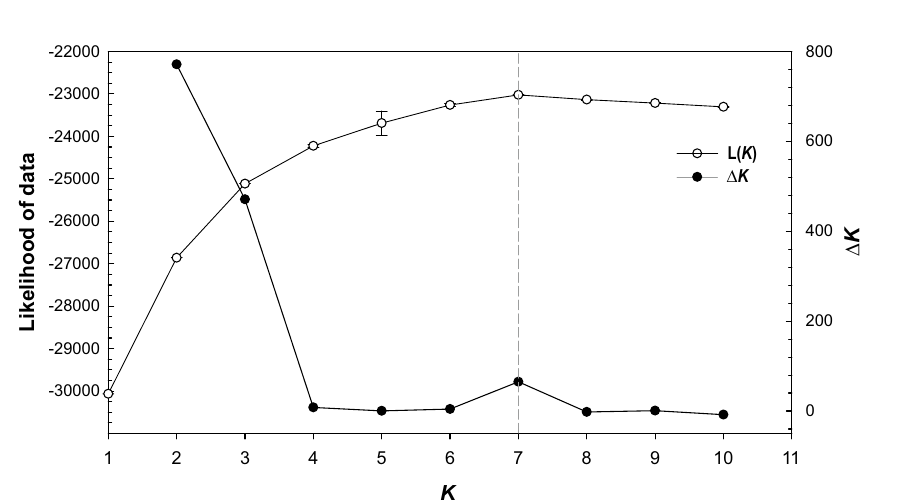
Figure 2. Inference of the number of unique genetic clusters ( K ) from structure simulations derived from ten SSR markers. Diagrams of posterior probability of SSR data were obtained according to the methods of Evanno et al 36 and Pritchard et al 37 . The likelihood of data given K (ln Pr(X| K ), in open circles) and Δ K (the standardised second order rate of change of the likelihood function with respect to K , in bold circles) are plotted as functions of K . Error bars of the ln Pr(X| K ) indicate standard deviations, but they are too small to be seen in the